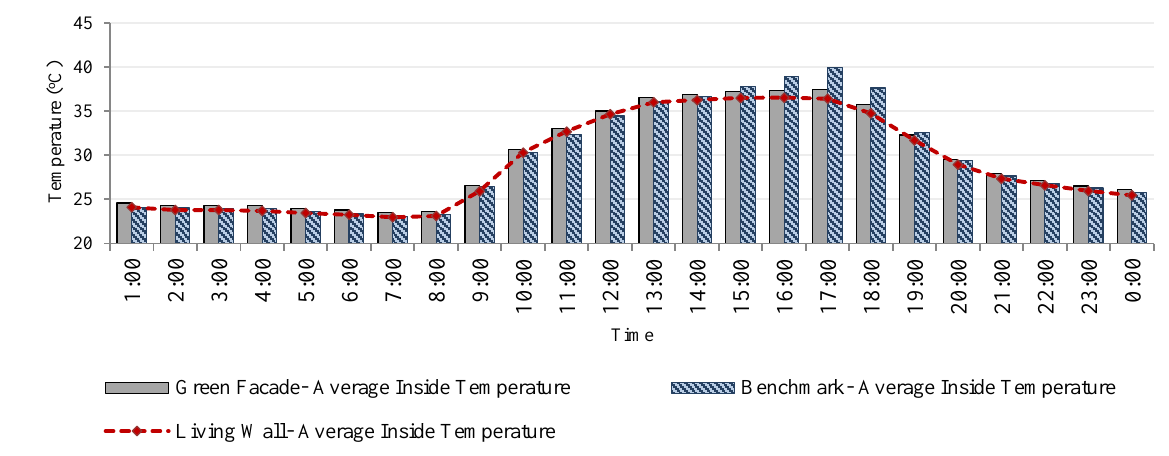
Fig. 5. Indoor temperature comparison of the boxes behind living wall, green facade and the benchmark when natural ventilation was used.